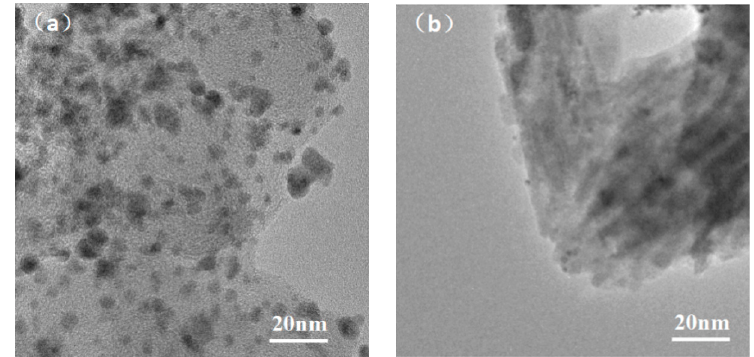
/ C and ( b ) γ -MnO 2 .